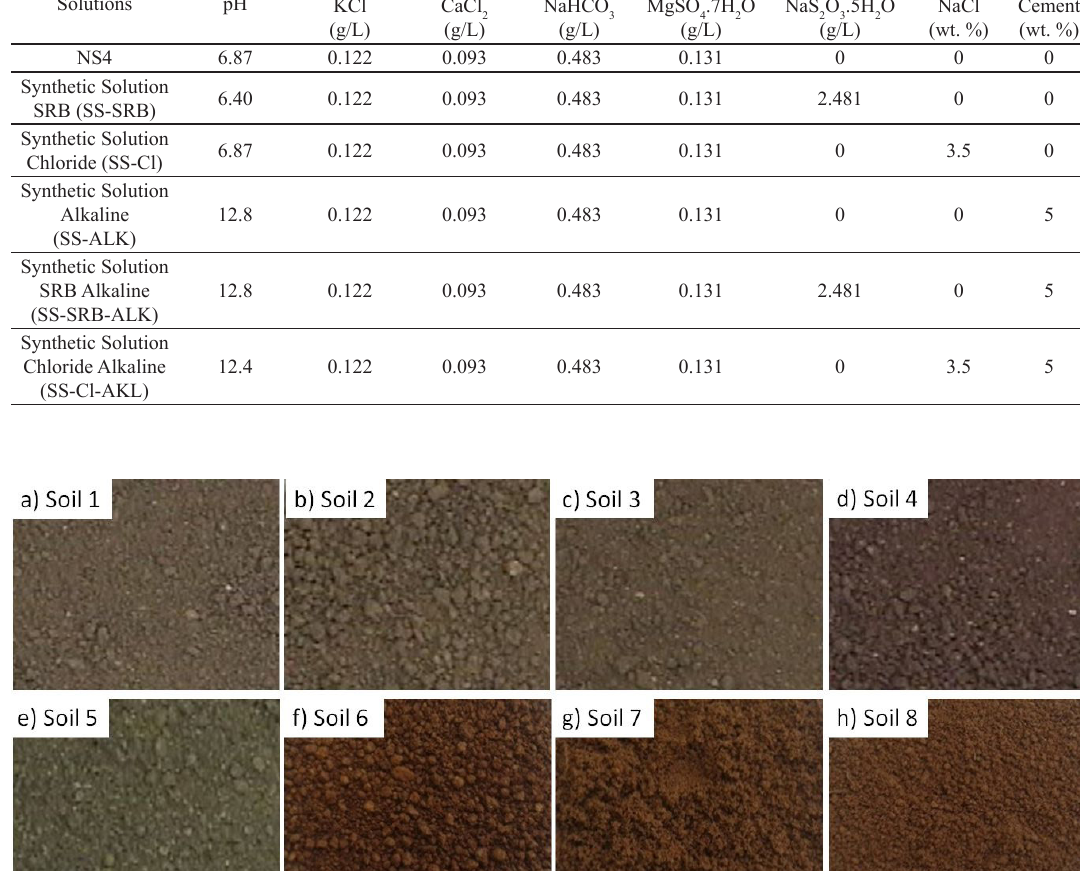
Table 3. Chemical composition of NS4 solution and the synthetic soil solutions proposed in this work. Solutions